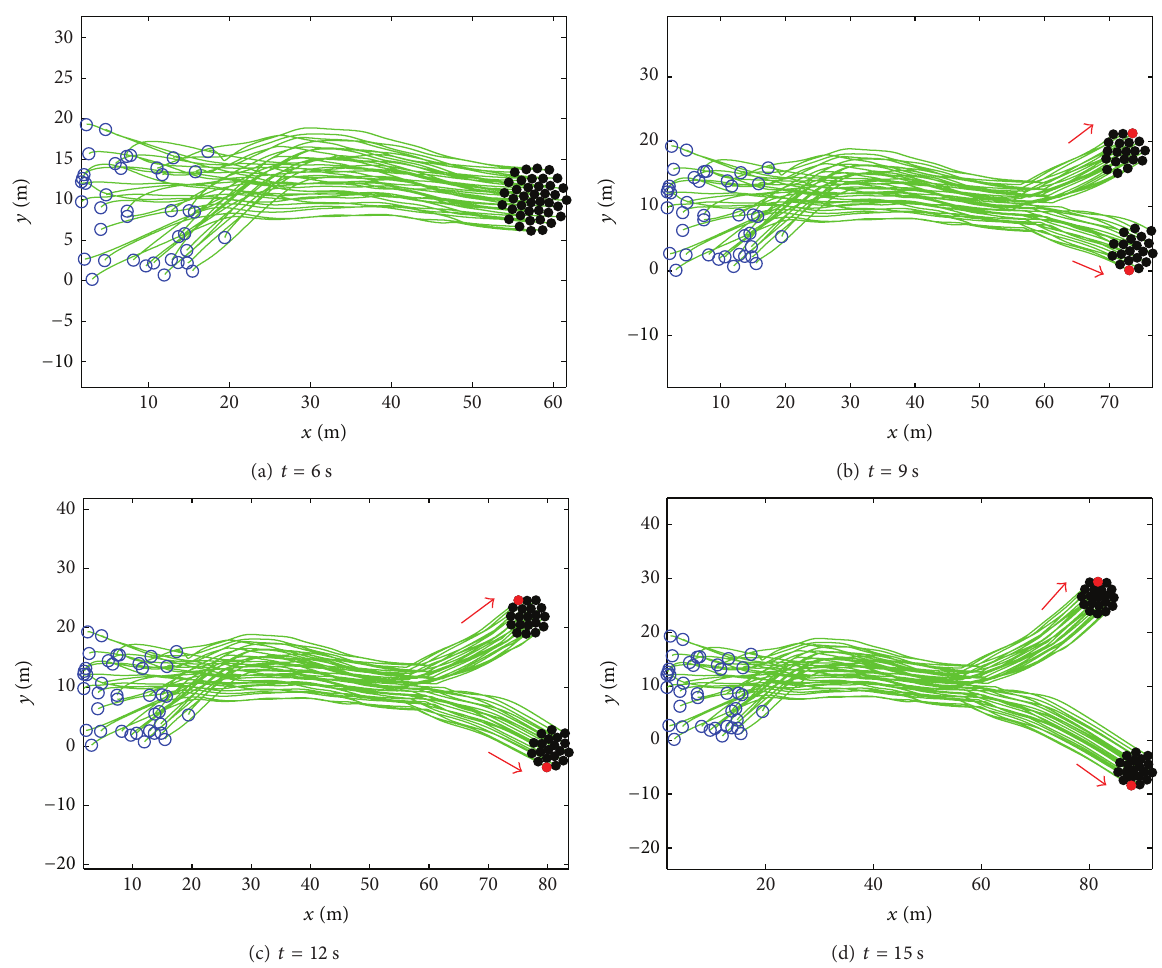
Figure 3: Snapshots of the trajectories of individuals during the fission process, where “ ∘ ” represents the initial position of individuals and “ ∙ ” denotes the final position of each individual. Specifically, “red dot” are the two individuals that sense external stimuli with “red arrow” being their desired